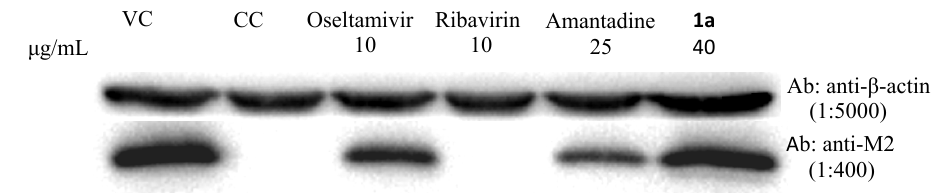
Figure 3. The effect of 1a on M2 protein expression in MDCK cell infected with influenza virus